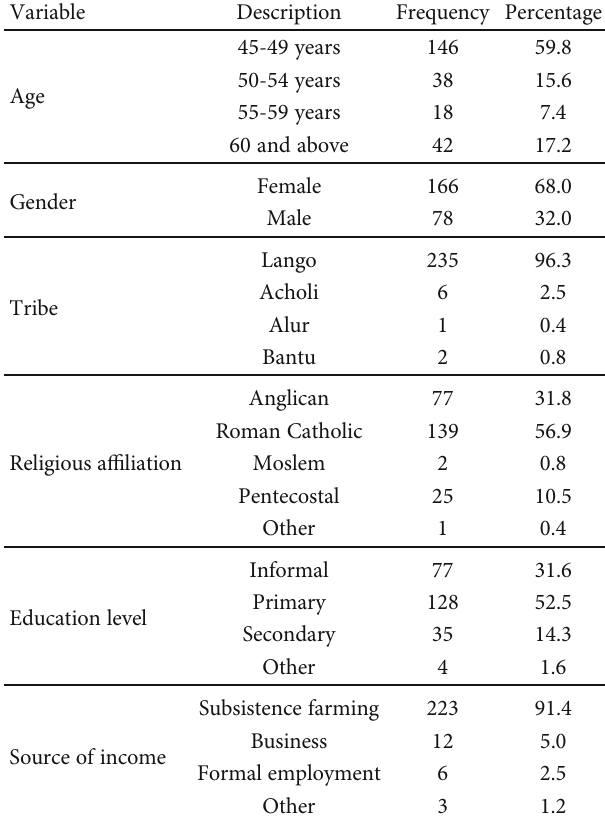
Table 1: Participants ’ sociodemographic pro fi